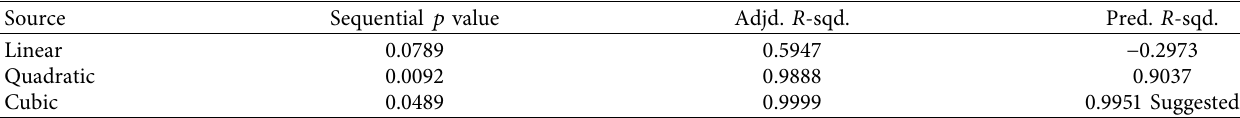
Table 10: Lack of fit for compressive strength response.